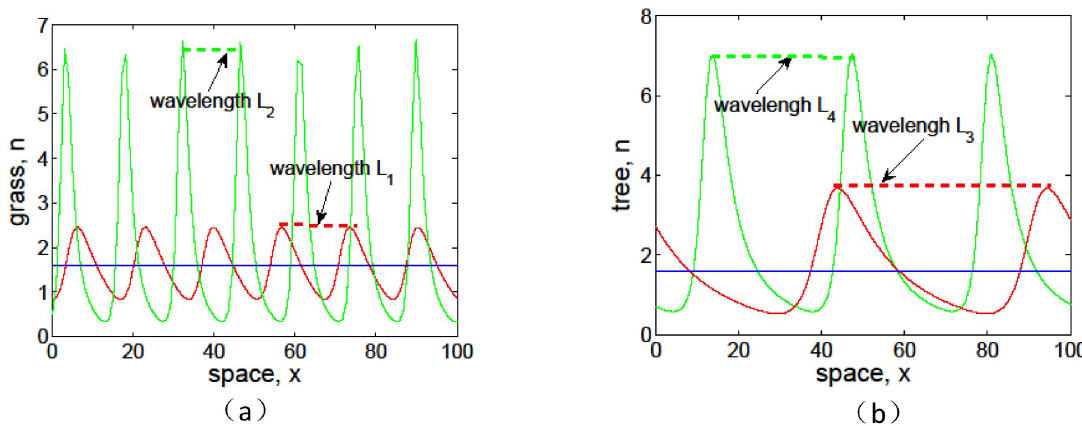
Fig 10. Effects of infiltration positive feedback coefficient α on the amplitude and wavelength of pattern solutions for biomass n . The blue curves correspond to α = 0, red curves correspond to α = 0.01 in (a) and (b), and the green curves correspond to α = 0.2 in (a) and α = 0.03 in (b). The fixed parameter values: (a) p = 1, δ = 0.45, v = 9, which corresponds to grass. (b) p = 0.1, δ = 0.045, v = 30, which corresponds to tree.